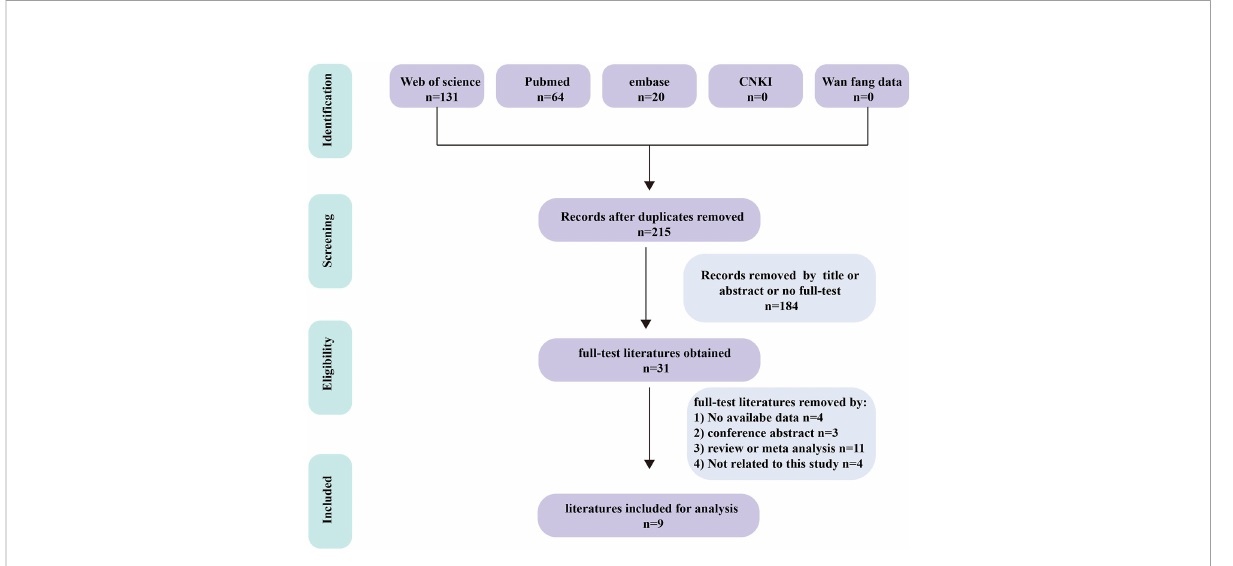
FIGURE 1 Flow diagram of the study selection for the present meta ‐